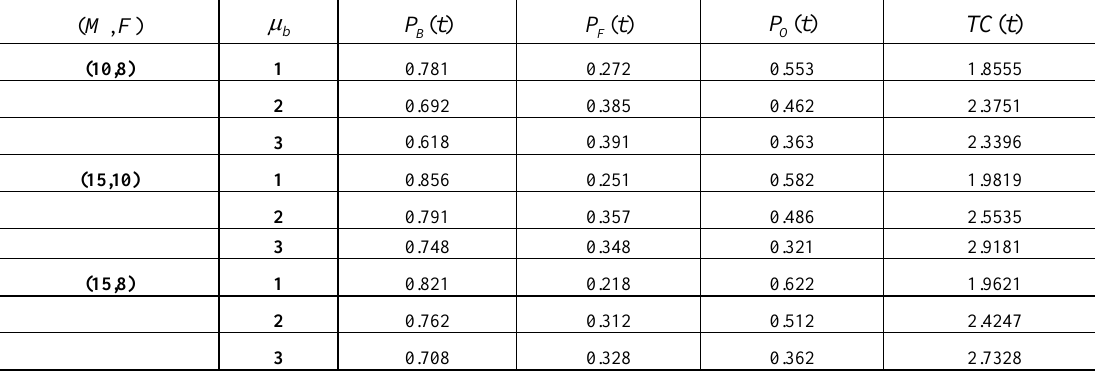
Table 1. Effect on performance measures by varying M, F and